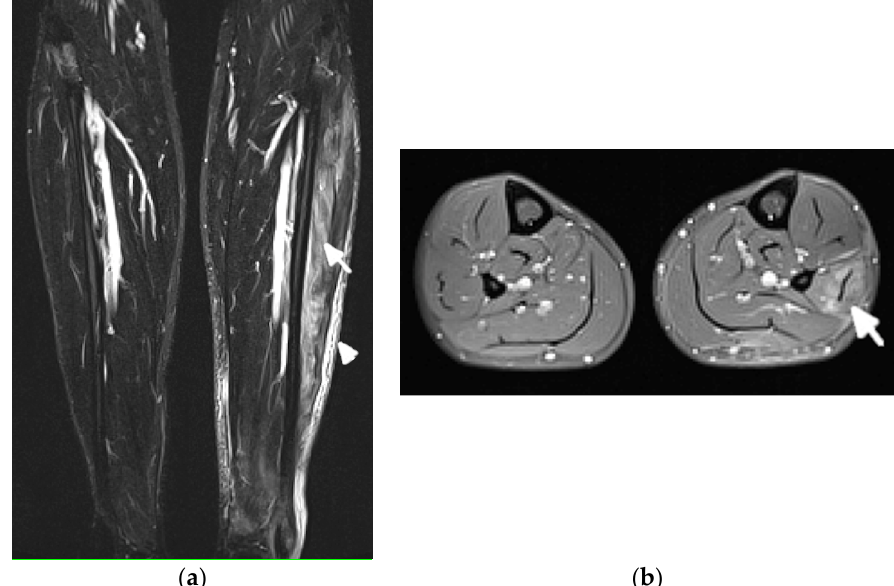
Figure 9. Magnetic resonance (MR) imaging of lower legs of a 34-year-old male with systemic lupus erythematosus with myositis. ( a ) Coronal T2 turbo inversion recovery magnitude and ( b ) axial postcontrast T1-weighted MR images with fat saturation show increased signals in the muscles of the lower left leg (arrows), especially peroneus brevis and the lateral head of gastrocnemius, and to a lesser extent, soleus musculature, with heterogeneous enhancement in ( b ) after the administration of a gadolinium base contrast agent. In ( a ), note the subcutaneous edema around the left lower leg (arrowhead).